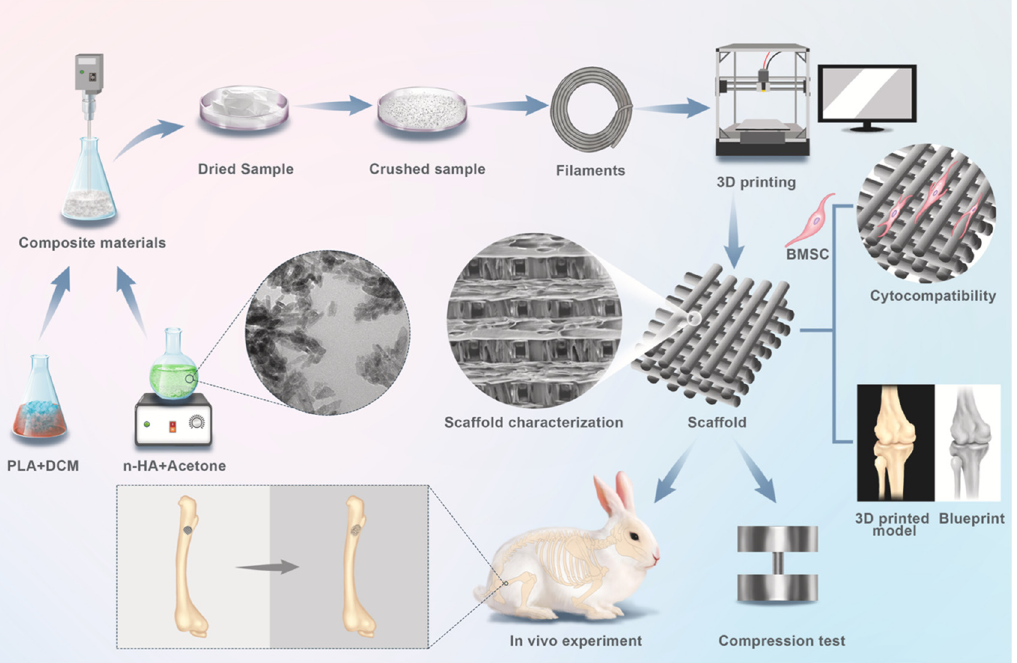
Figure 25. Schematic illustration of preparation and application of PLA/n-HA scaffolds for bone regeneration. The PLA/n-HA composite material was prepared by the wet mixing method, and the 3D-printed composite scaffold was made by PLA/n-HA filament. The material characterization and in vivo and in vitro experiments of the composite materials successively verified the sufficient mechanical strength and non-toxicity suitable for the promotion of the repair of bone defects [55].